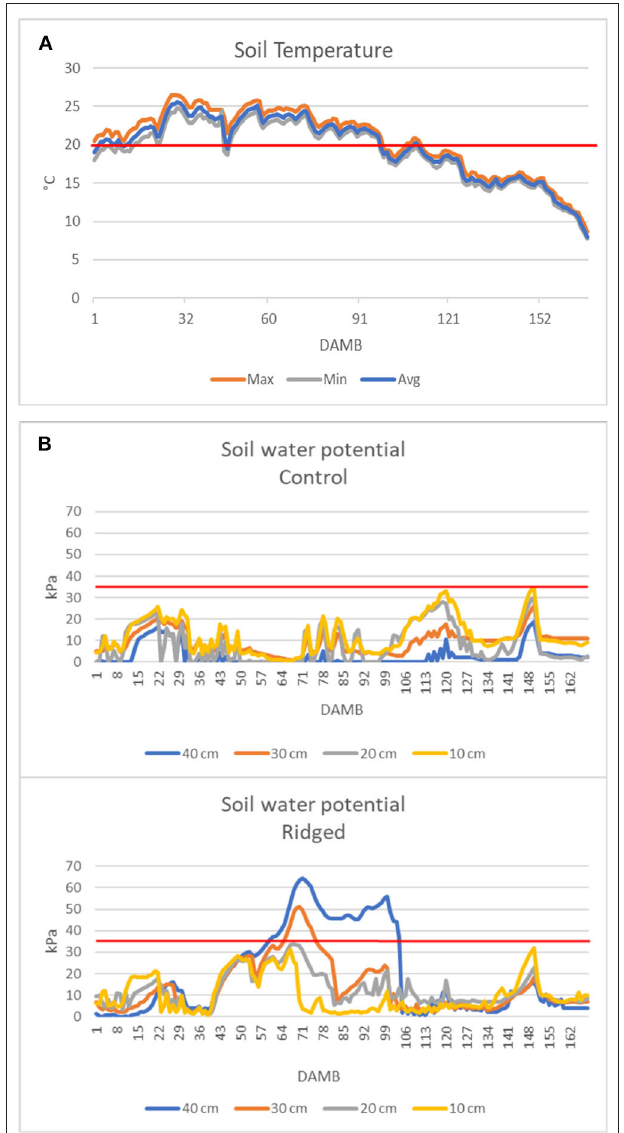
potential measured at 10, 20, 30, and 40cm depth in the Control (C) and Ridged (R) plots (B) . The red line indicates the temperature at which root growth stops (Smith et al., 1989) (A) or the soil water potential at the field capacity (B)